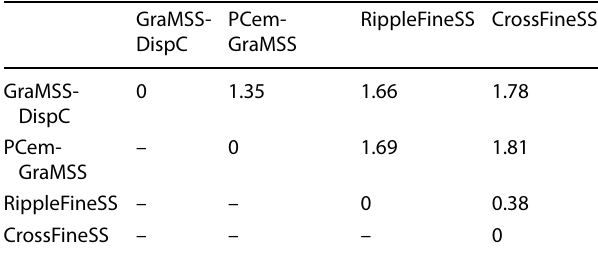
Table 5 Similarity matrix computed using the confusion matrix in Table 4 GraMSS- DispC